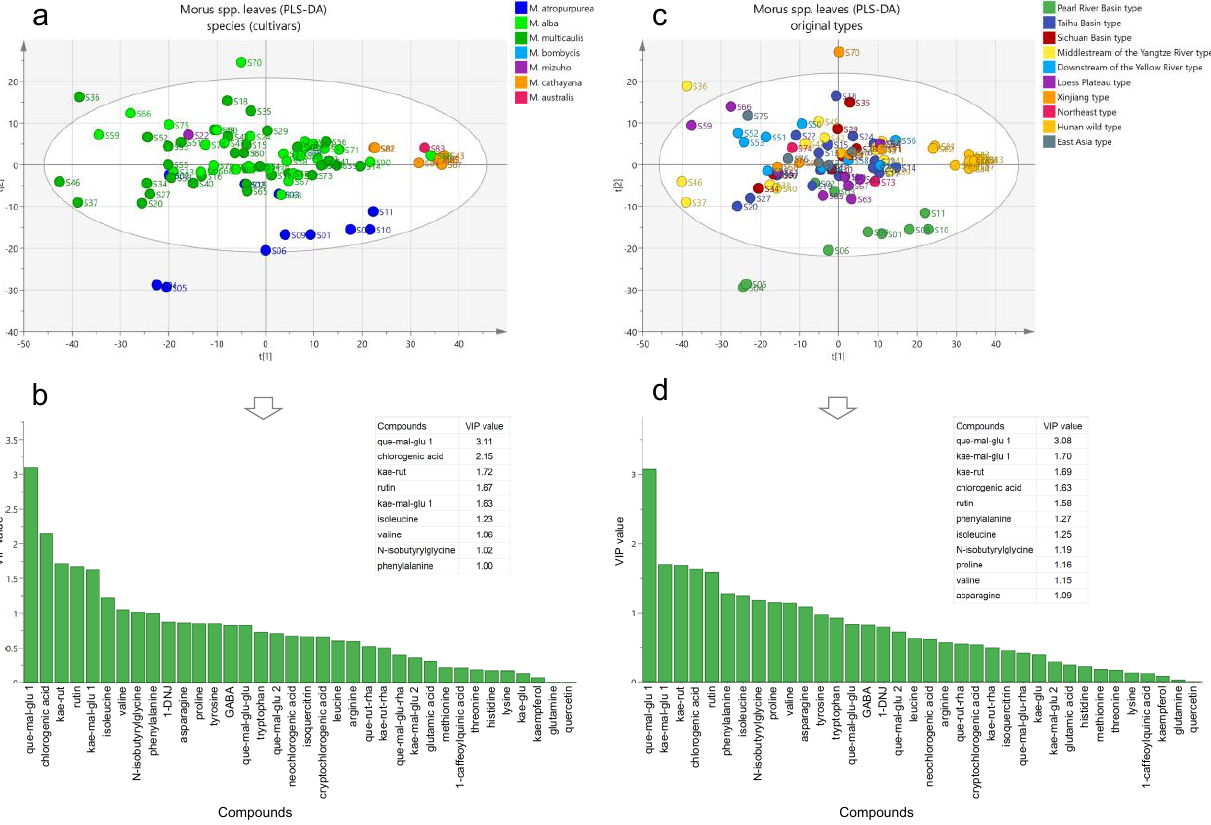
Figure 6. PLS-DA score scatter plot for different species of Morus spp. leaves ( a ) and VIP value of compounds ( b ); PLS-DA score scatter plot for different original types of Morus spp. leaves ( c ) and VIP value of compounds ( d ).